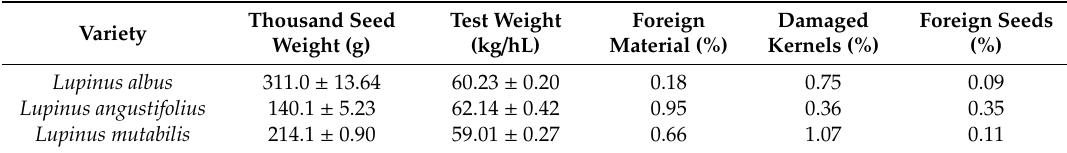
Table 2. Physical characteristics of Lupinus seeds for three di ff erent varieties: albus , angustifolius, and mutabilis